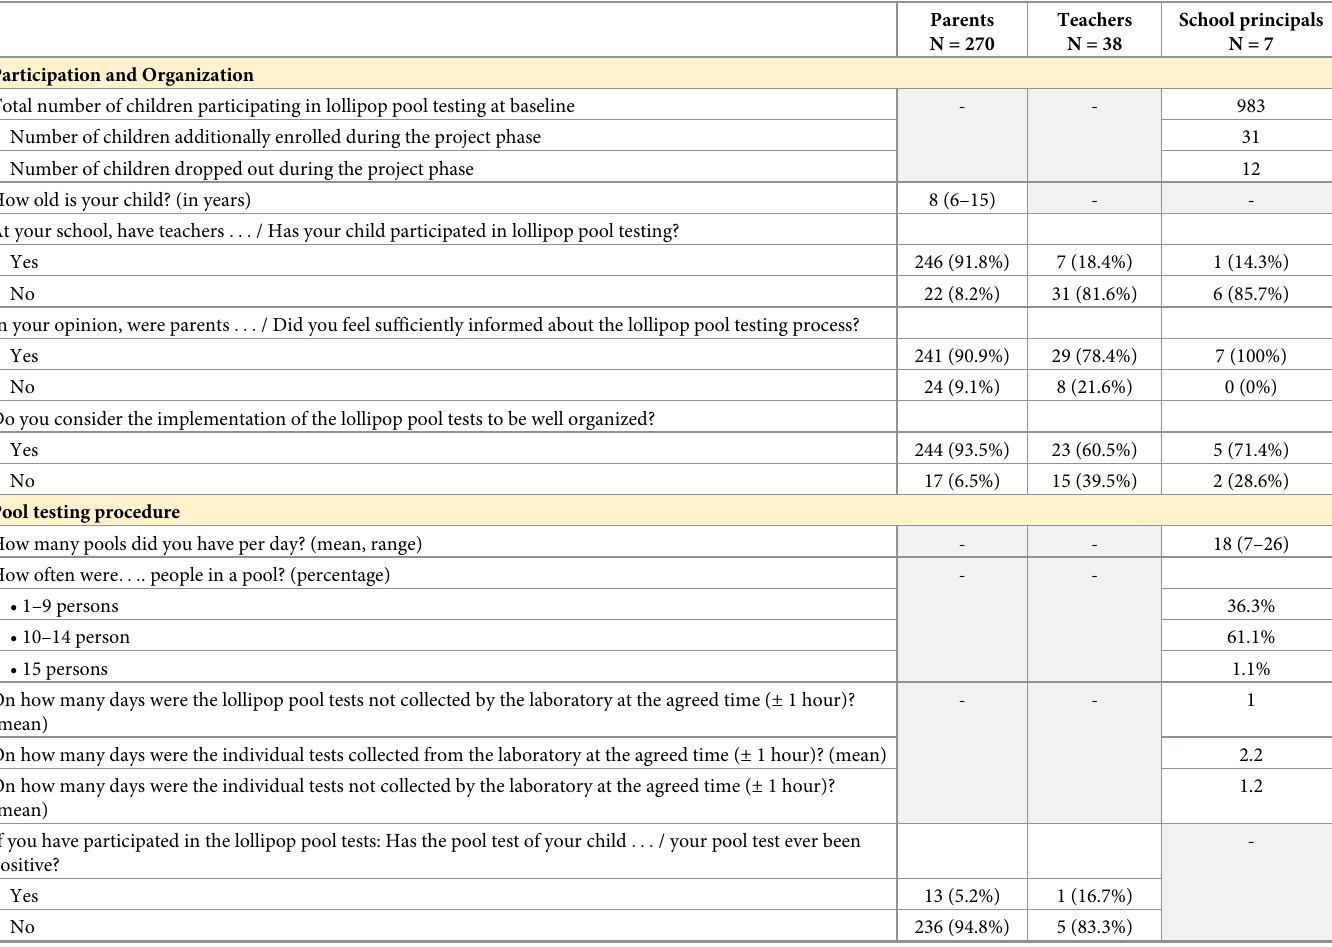
Table 2. Quantitative results of questionnaires from parents, teachers and school principals evaluating the lollipop pool PCR testing pilot project.